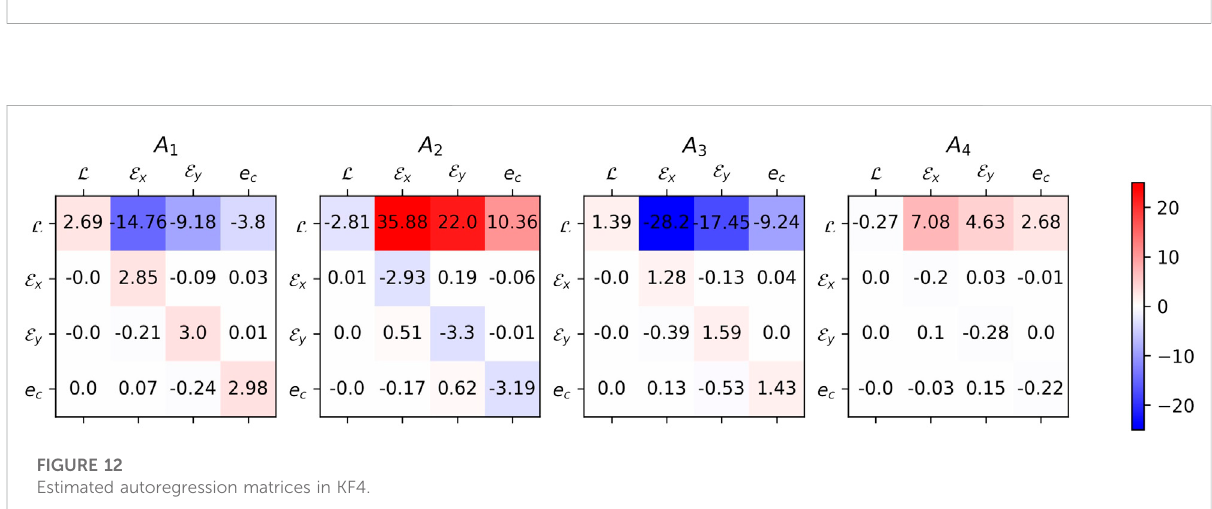
KF4 trained on the data of 2018, prediction on the fi lls 6726, 6674, 6677, and 6681 of 2018 and corresponding input control parameters. Pink points correspond to T 0 observations which the model uses to get initial KF smoother results. Further model propagates without seeing the loss and other output values, with control parameters given as the input. Two standard deviation con fi dence bands are shown in light blue.